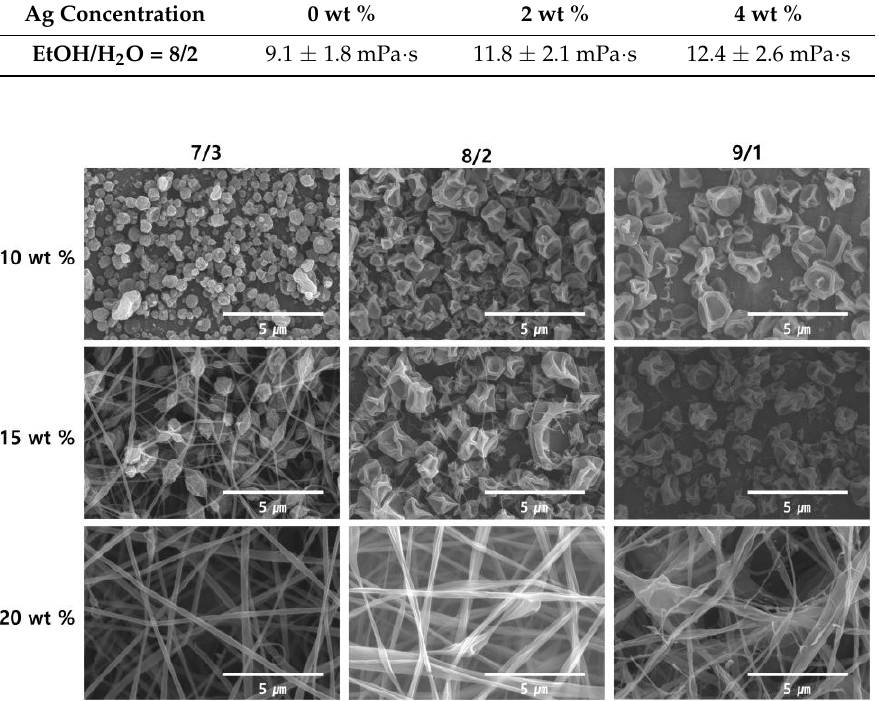
Figure 3. Transmission electron microscopy images of zein/Ag nanoparticles electrospun from ethanol aqueous solutions with an ethanol/water ratio of 8/2 ( v/v ) at Ag concentrations of ( a ) 0, ( b ) 2 and ( c ) 4 wt % (polymer concentration = 10 wt %, TCD = 15 cm, and applied voltage = 15 kV).